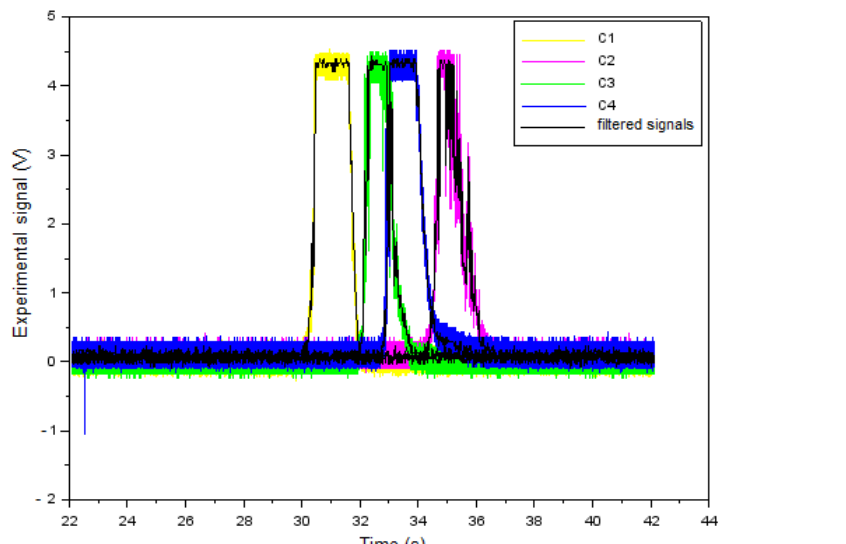
Figure 2. Example of the obtained raw data from optical fibre.